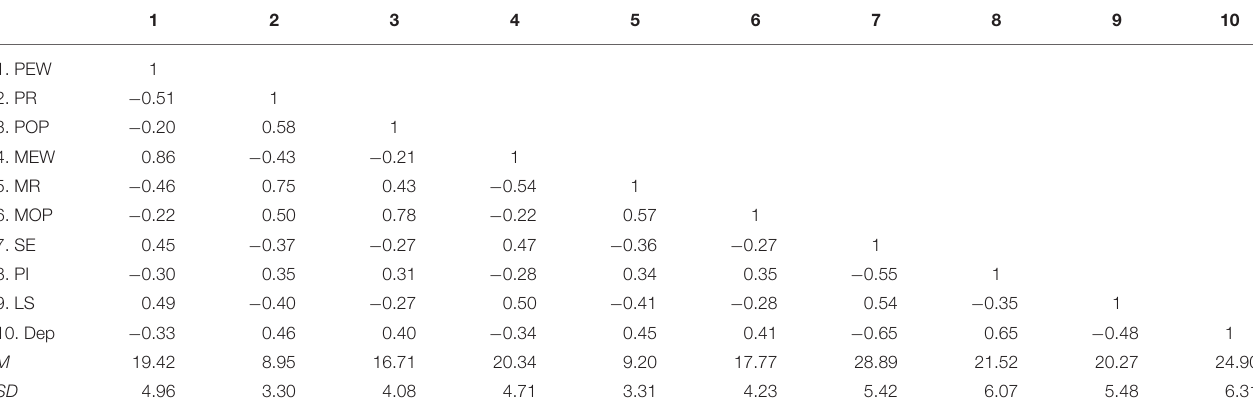
TABLE 1 | Means, standard deviations, and correlations among the main variables.